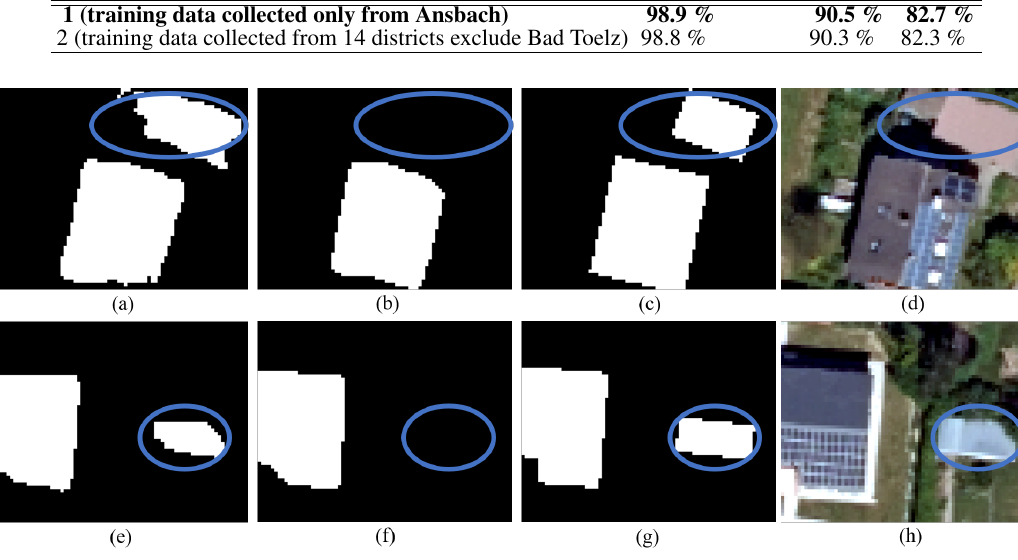
Figure 4. The buildings in Ansbach obtained from (a), (e) Trained model 1, (b), (f) Trained model 2, and their corresponding (c), (g) DFK as ground reference as well as (d), (h) TrueDOP.